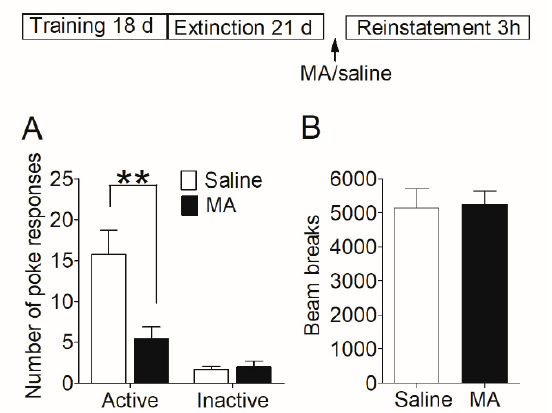
Figure 3. Intravenous injection of MA before the reinstatement test blocked the reinstatement of morphine seeking induced by morphine-priming injection and had no significant effect on locomotor activity. ( A ) Number of nose-pokes in saline group ( n = 15) and MA group ( n = 13) in the reinstatement session. Asterisks indicate a significant difference ( ** p < 0.01) in the number of active pokes between MA group and saline controls. ( B ) The level of locomotor activity in the reinstatement session. There was no significant difference between the two groups. Data are expressed as mean ± SEM.